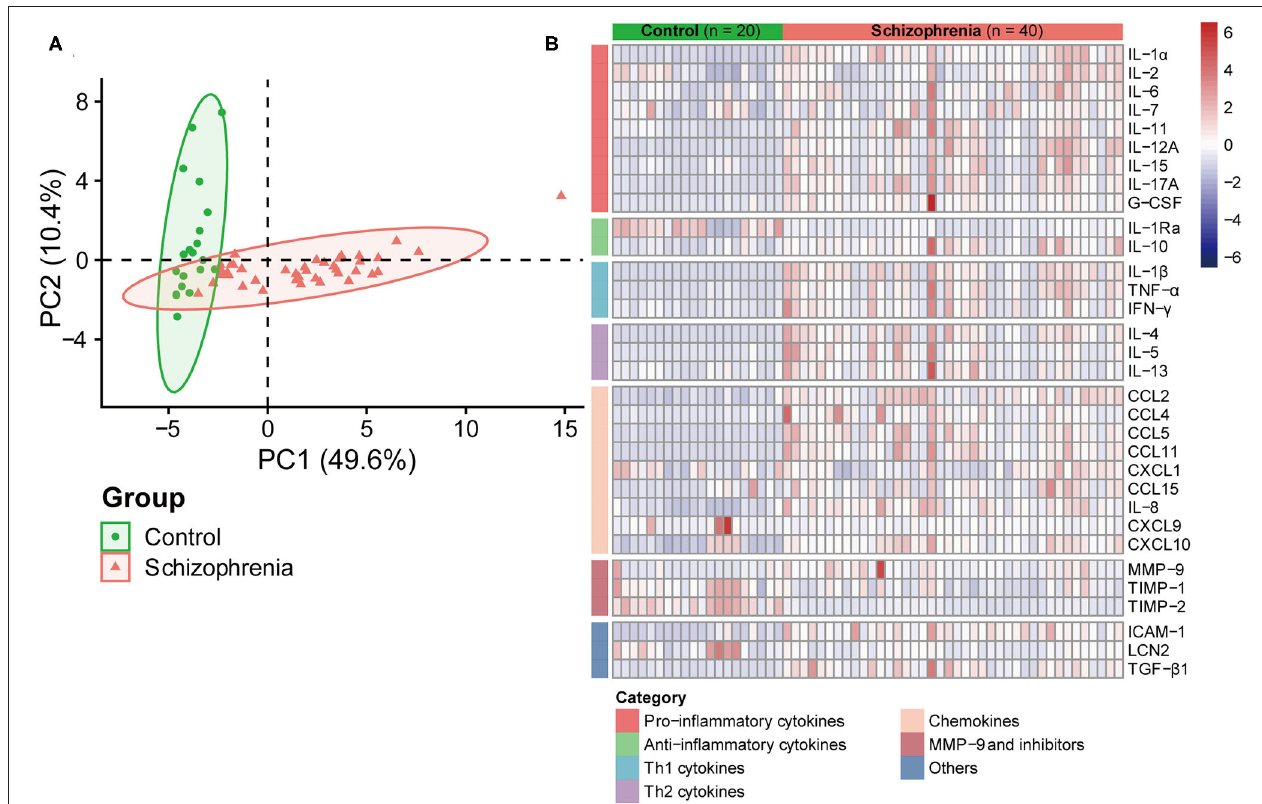
FIGURE 1 | Cytokines profile in tears of subjects with and without schizophrenia. (A) Principal component analysis was performed by the concentration of 32 cytokines in tears. Scatter plot of principal component 1 (PC1) and PC2 were represented, and each dot represented a sample projected in them. The orange and green dots represented schizophrenia and control groups, respectively. (B) Heatmap of high and low concentrations of tear cytokines. The groups evaluated were controls ( n = 20) and patients with schizophrenia ( n = 40). High levels of cytokines were shown in red on the heatmap, while low levels were shown in